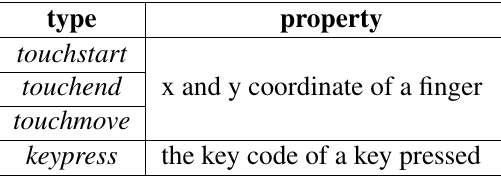
Table 4. An example of event properties